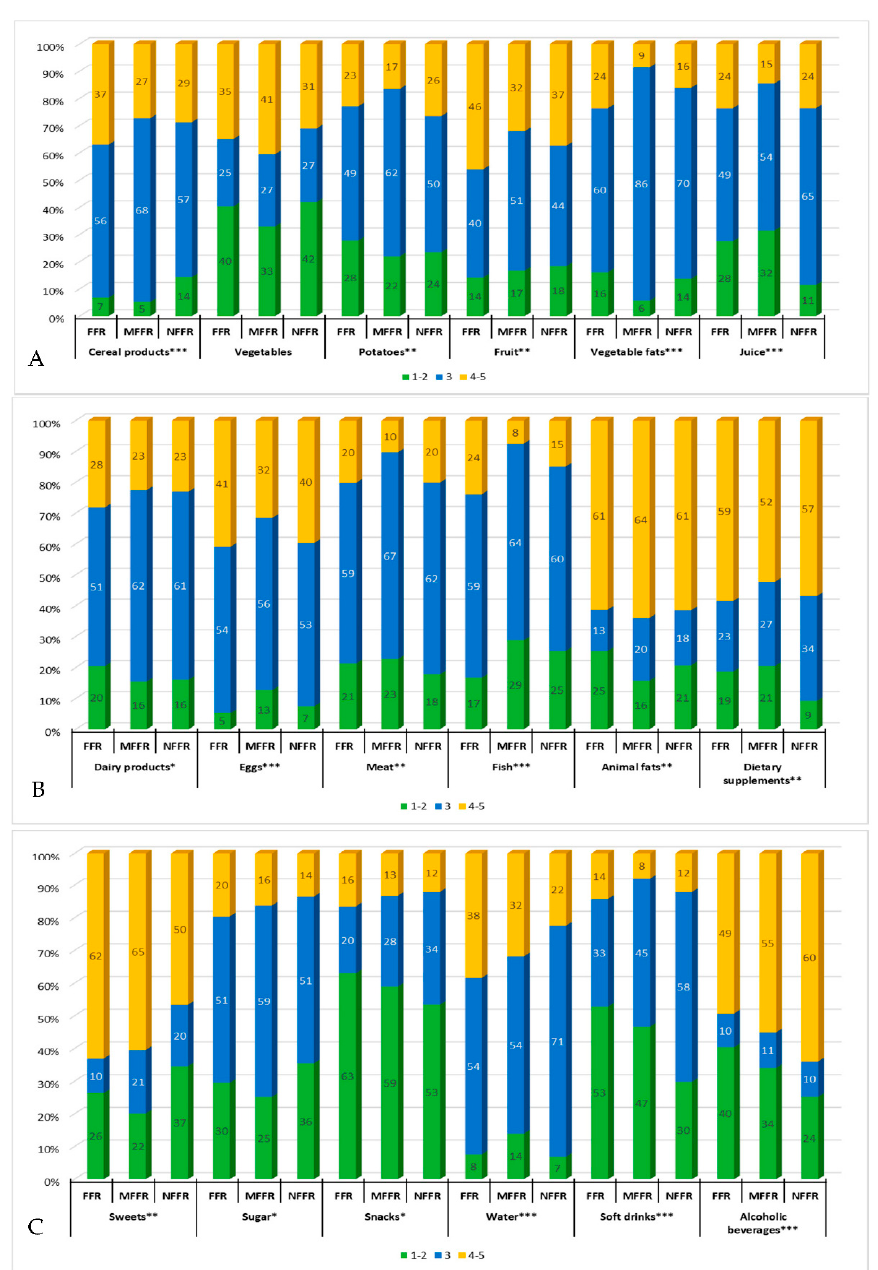
Figure 4. ( A – C ). Changes in the level of food product consumption, alcoholic beverages, and dietary supplements. FFR— Fearing and following the rules, MFFR—Moderately fearing and following the rules, NFFR—Not fearing and not follow- ing the rules. The direction of changes: 1—much less, 2— less, 3—no changes, 4—more, 5—much more. Statistically sig- nificant in the chi square test at: *** < 0.0001, ** <0.01, * <0.05.